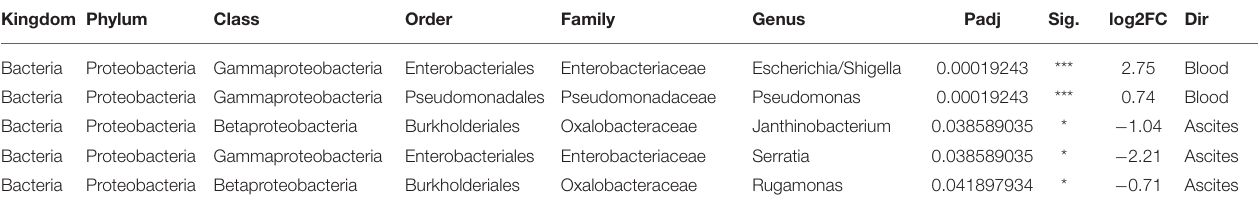
TABLE 3 | Differentially abundant genera between ascites and